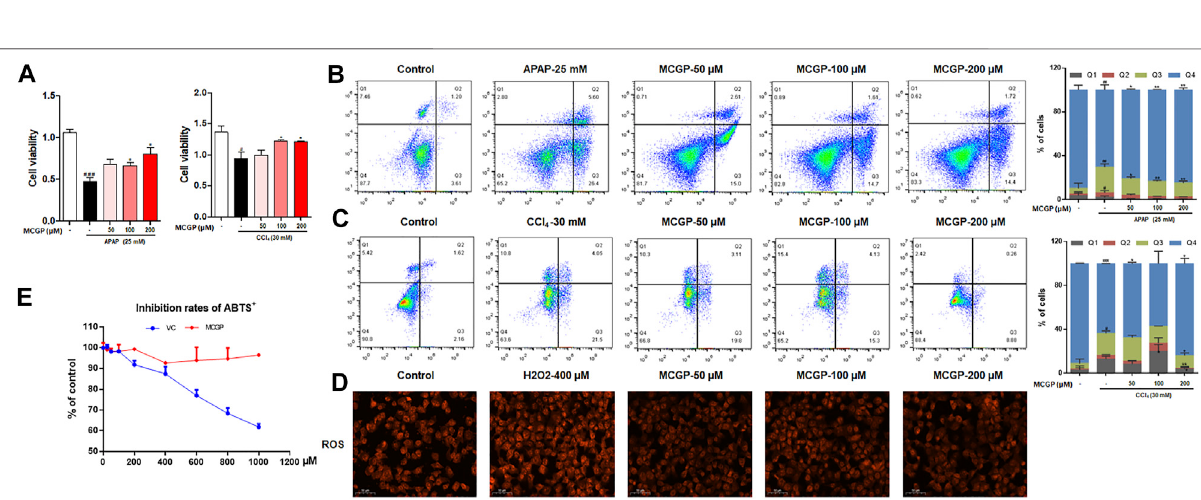
FIGURE1|(A) SyntheticrouteandstructureofMCGP. (B-D) CytotoxicityofMCGPon7,721 (B) ,THP-1 (C) ,andLX-2 (D) cellsat25 – 1,000 μ M. (E,F) Cytotoxicity of MCGP on HepG2 (E) and AML12 (F) cells at 25 – 400 μ M. Data were presented as the mean ± SEM. * p < 0.05, ** p < 0.01, *** p < 0.001 vs